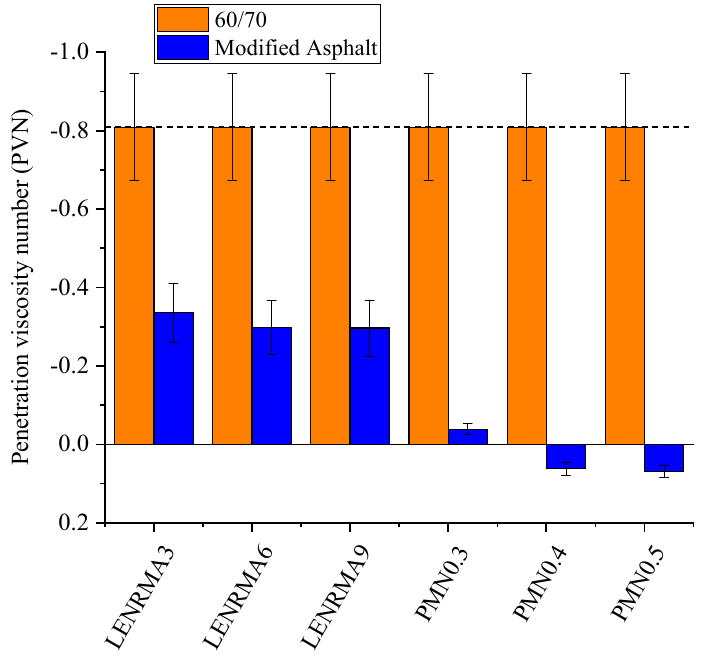
Figure 7. Penetration viscosity number of all binders.